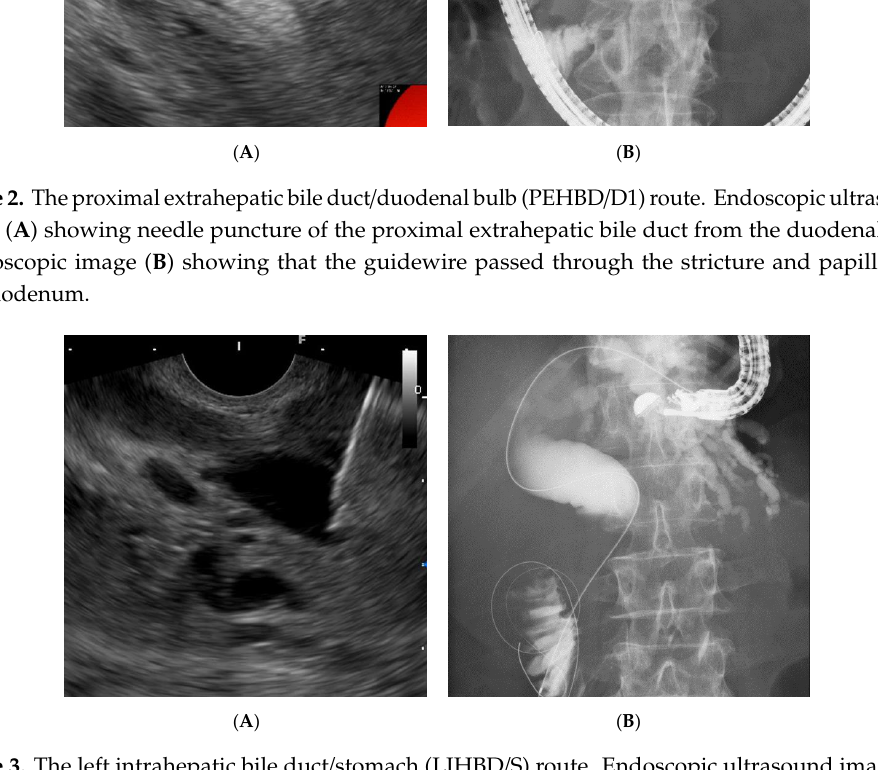
( B ) Figure 4. The right intrahepatic bile duct/duodenal bulb (RIHBD/D1) route. Endoscopic ultrasound image ( A ) showing needle puncture of the right intrahepatic bile duct (B6) from the duodenal bulb. Fluoroscopic image ( B ) showing that the guidewire passed through the stricture and papilla into the duodenum. 2.5. Biliary Cannulation Methods during EUS-RV We used three cannulation methods including over-the-wire, along-the-wire, and hitch-and-ride [16]. In the over-the-wire method, an EUS-placed guidewire was caught by a snare and pulled through a channel of a duodenoscope, followed by the insertion of a catheter over the guidewire. In the along-the-wire method, standard WGC was applied along the EUS-placed guidewire. There are potential disadvantages in both methods: the risk of guidewire loss and time consumption in the former, and the unreliability of the biliary cannulation in the latter. To solve these problems, we used the hitch-and-ride method from April 2019, using a hand-made catheter that had a slit on the tip